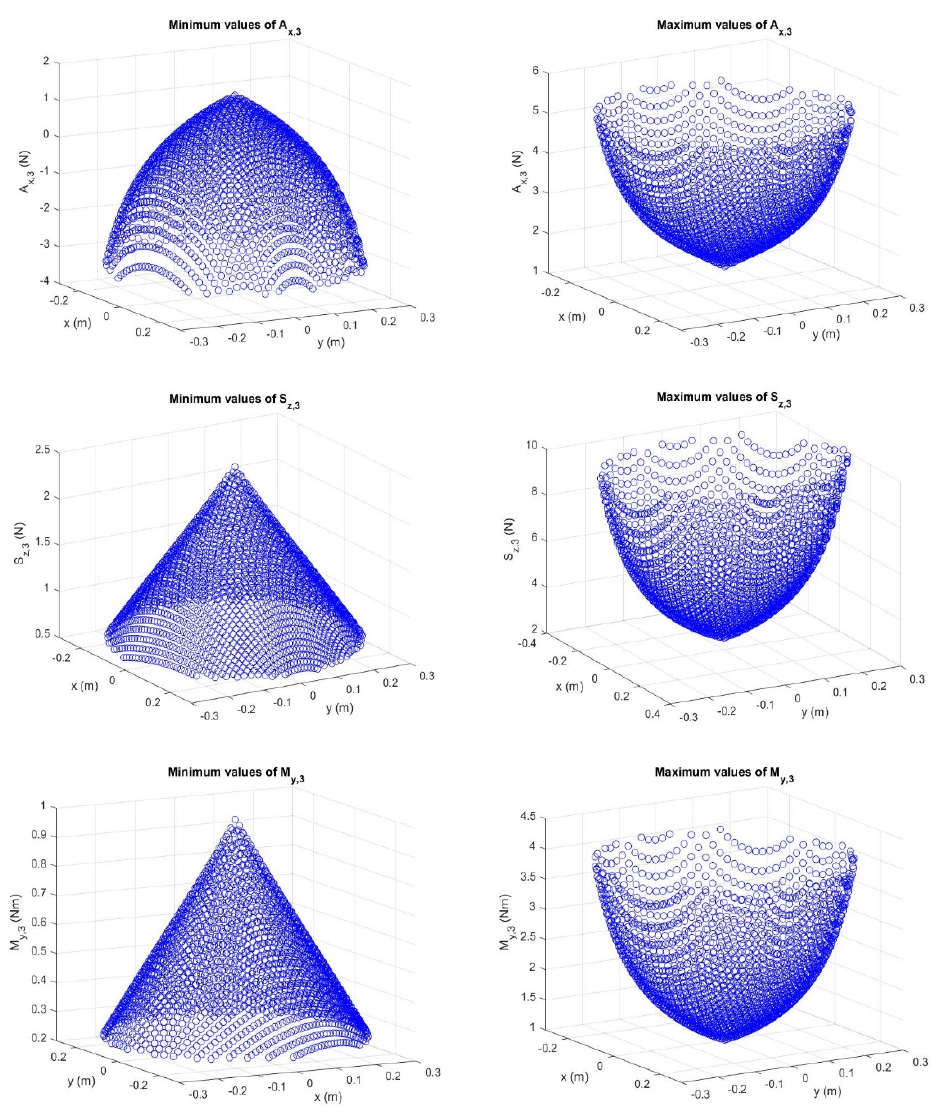
Figure 6. Case M e,z = 1: minimum and maximum values of A x,3 , S z,3 , and M y,3 computed for 3220 positions of A 1 (=(x p , y p )) uniformly distributed inside the useful-workspace circle. Internal Loads in the RRC Limb